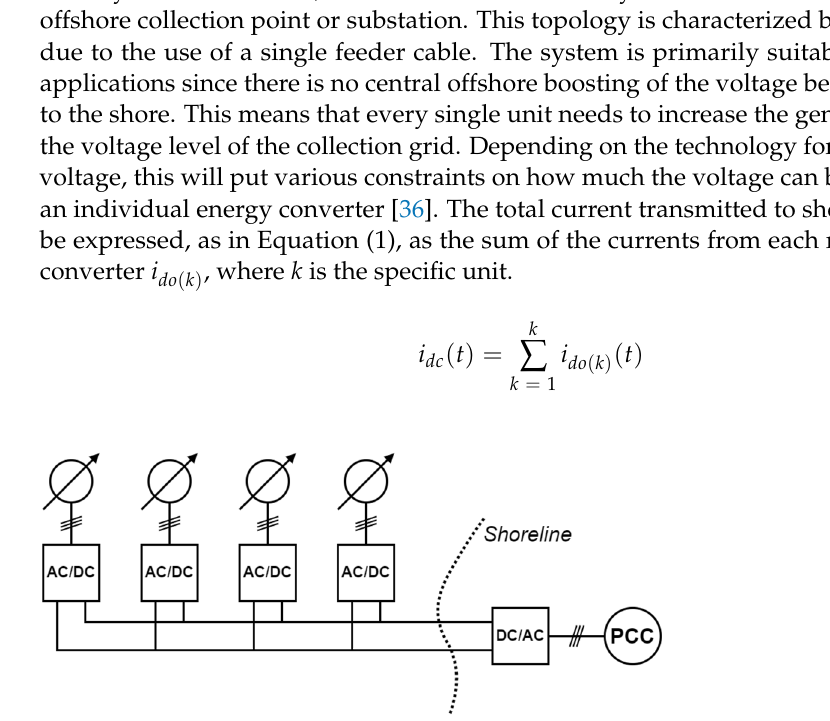
Figure 6. Simple parallel DC collection grid.